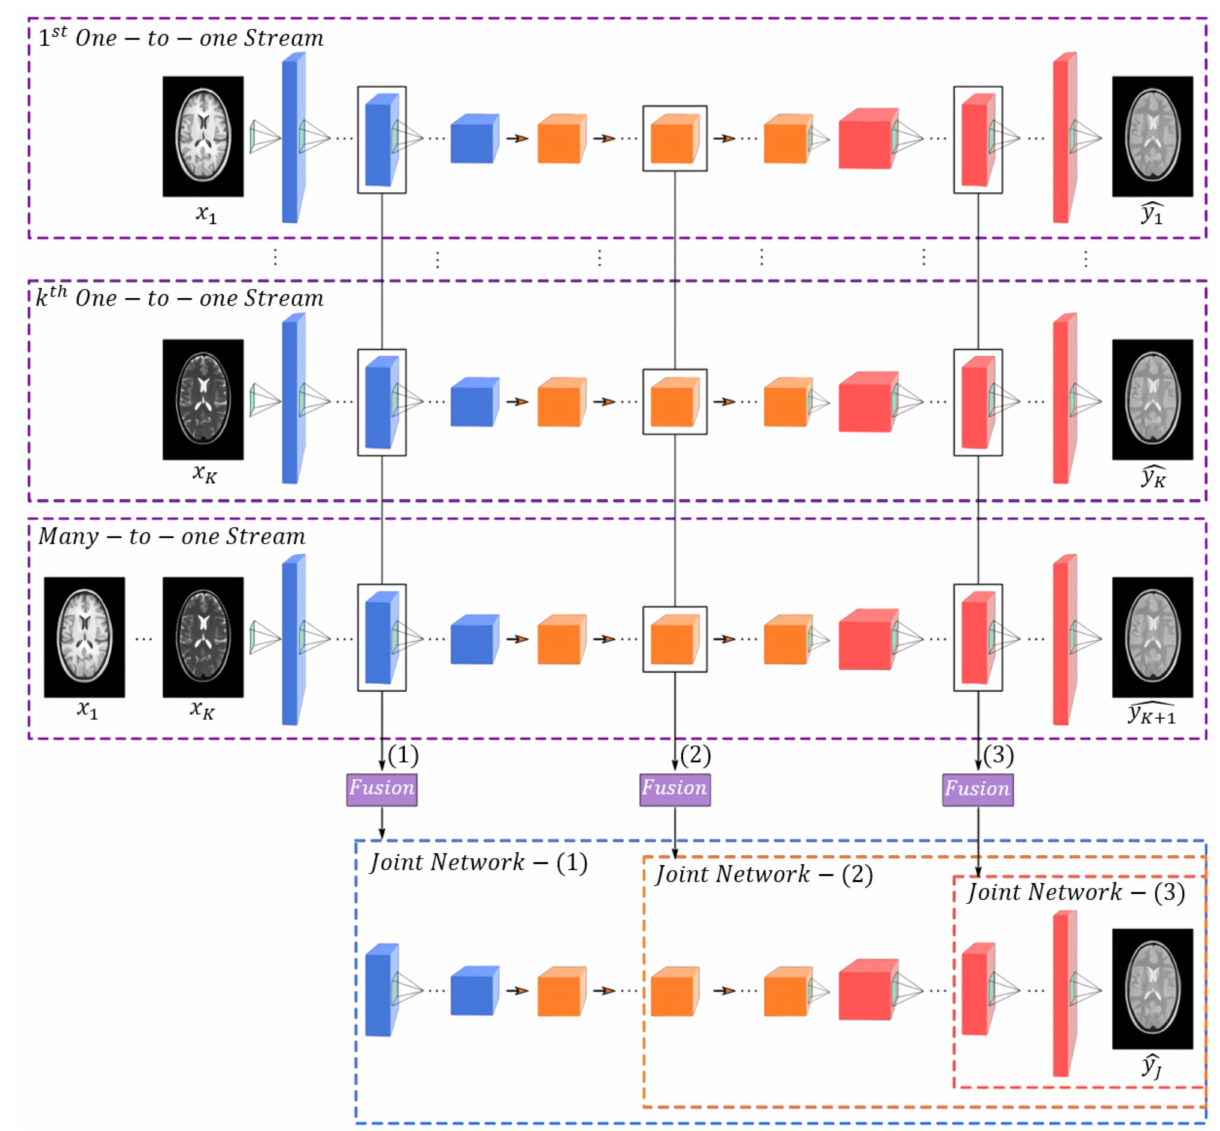
Figure 20. Structure and principle of mustGAN (multi-stream Generative Adversarial Networks)